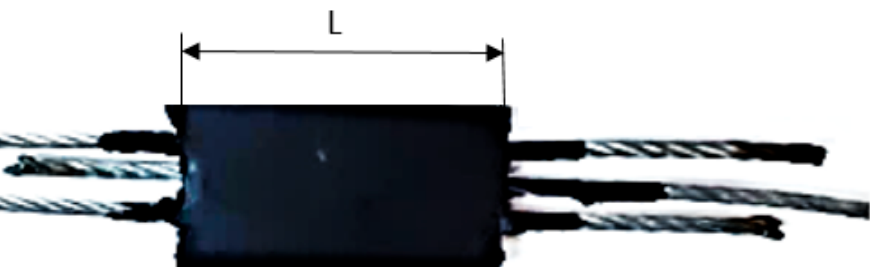
Figure 18. The shape of the sample used to determine the adhesion of the rubber to the metal insert.